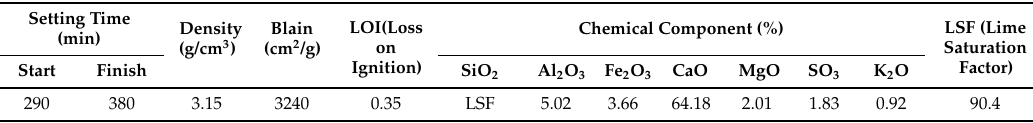
Table 4. Physical and chemical properties of OPC.